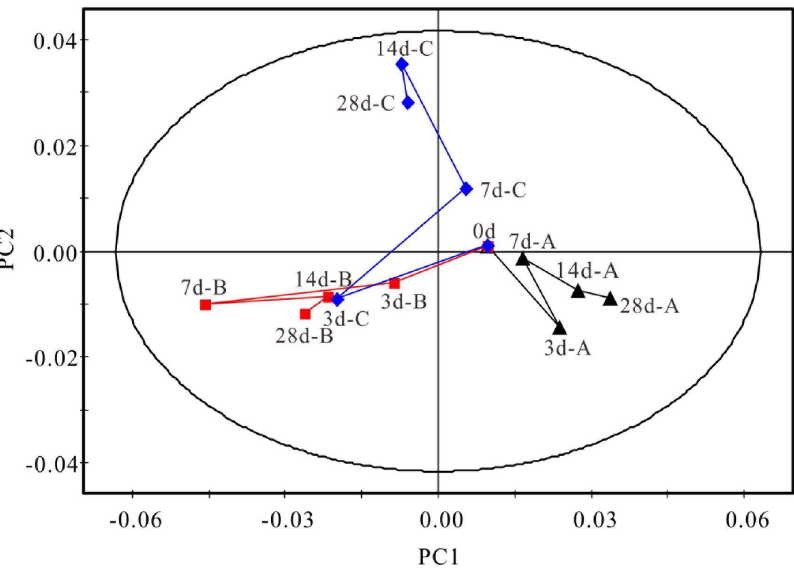
Figure 3. Time trajectory plot of mean data of serum 1 H CPMG spectra from SO ( m A), UUO ( & B) and CAO ( X C) rats, respectively. The plot suggests time-dependent metabolic characteristics of different group rats.